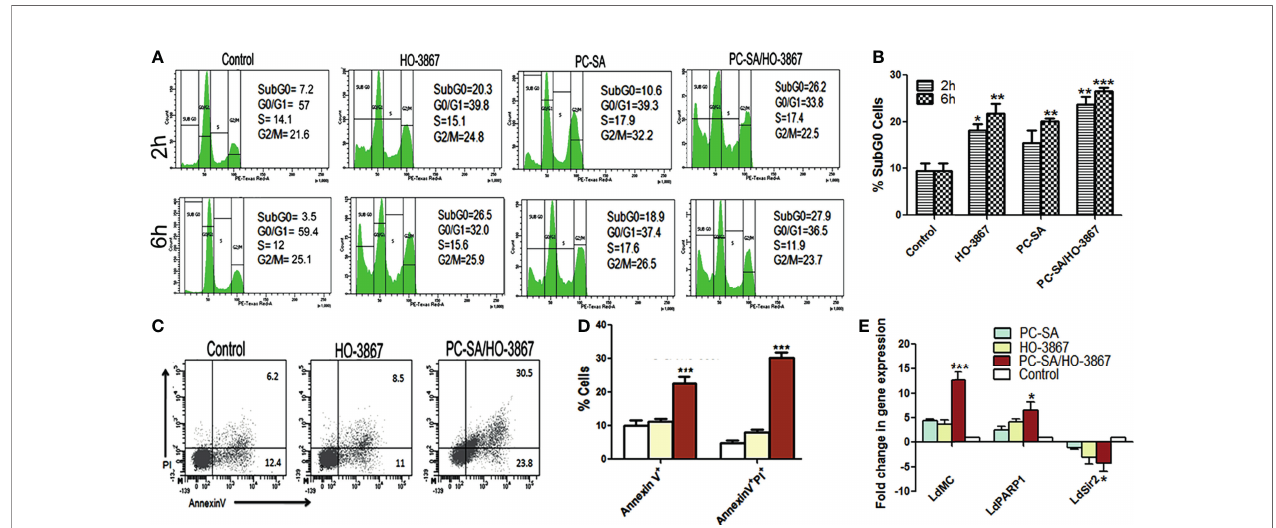
FIGURE 3 | Analysis of cell cycle arrest and mechanism of cell death in free and liposomal HO-3867-treated L. donovani promastigotes. (A) Cell cycle distribution of log-phase parasites after treatment with or without liposomal HO-3867 for 2 and 6 h. (B) Statistical analysis of subG0 accumulation in cell cycle distribution measured by fl ow cytometry after free drug and PC-SA/HO-3867 treatment. (C) Representative fl ow cytometry dot plots showing promastigotes left untreated or treated with 10 µg/ml of free or PC-SA liposome-entrapped HO-3867 for 2 h were stained with Annexin V-FITC and PI. (D) Early (Annexin V + PI - ) and late apoptosis (Annexin V + PI + ) of promastigotes after Annexin V-FITC/PI staining following treatment with 10 µg/ml of free drug or PC-SA/HO-3867. (E) Fold change of L. donovani metacaspase (LdMC), LdPARP1, and LdSir2 genes relative to internal GAPDH control in drug-treated parasites compared to controls. Data (mean ± S.E.) are one of the three independent experiments. * p < 0.05, ** p < 0.001, *** p < 0.0001 compared to saline control, assessed by one-way ANOVA and Tukey ’ s multiple- comparison